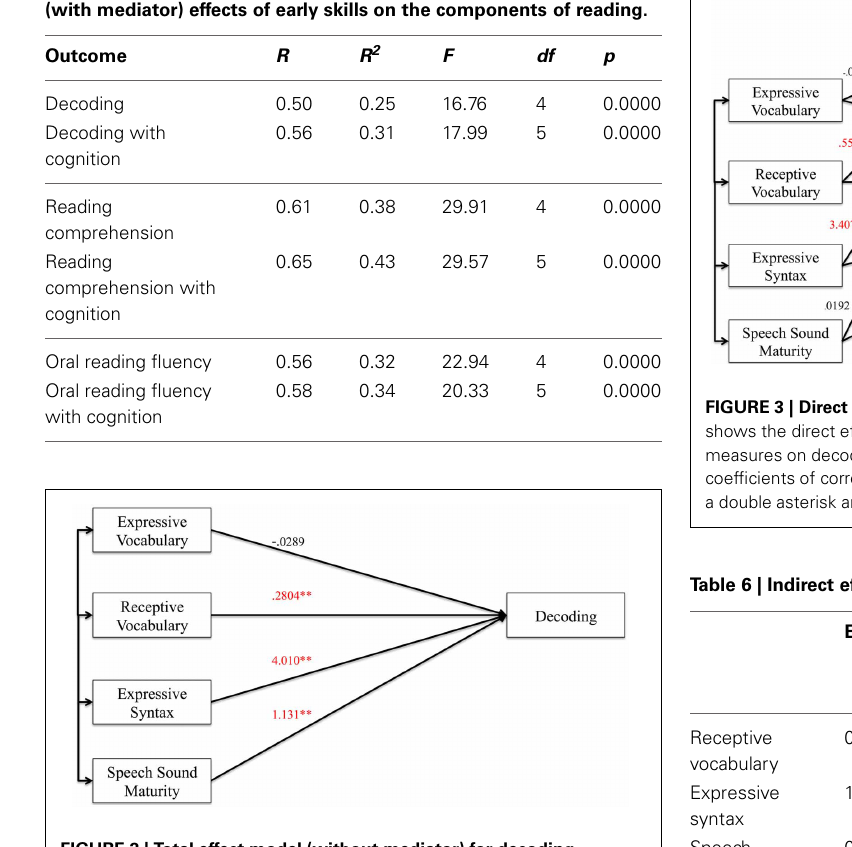
FIGURE 2 | Total effect model (without mediator) for decoding. Figure 2 shows the total effect model for preschool language and speech measures on decoding. Unstandardized coefficients of correlations are included in model. Coefficients marked with a double asterisk are significant at the p < 0 . 01 level.